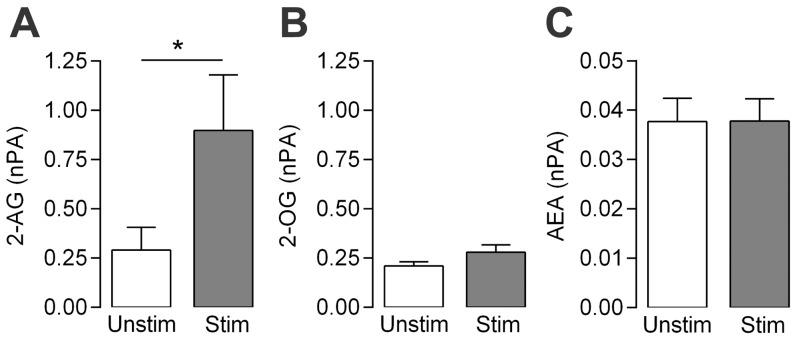
Bradykinin and ATP selectively increase the content of 2-arachidonoylglycerol in rat dorsal root ganglia.Isolated dorsal root ganglia from newborn rats were incubated with a mixture of 10 µM bradykinin and 1 mM ATP (Stim), or vehicle (Unstim) for 2 min and the contents of 2-arachidonoylglycerol (2-AG, A), 2-oleoylglycerol (2-OG, B) and anandamide (AEA, C) determined by mass-spectrometry. Y-axis indicates normalized peak area (nPA). Data are presented as mean ± s.e.m. (n = 6). Paired Student's t-test on log transformed values was used for comparing groups of data. *P<0.05